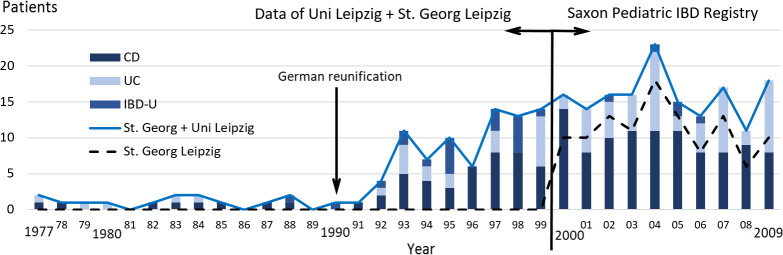
Increasing number of IBD patients in Leipzig/Saxony.Origin of the data: St. Georg Hospital, Leipzig, Germany, University Hospital for Children and Adolescents, University of Leipzig; Data till 1999 [3], since 2000 Saxon Pediatric IBD Registry.